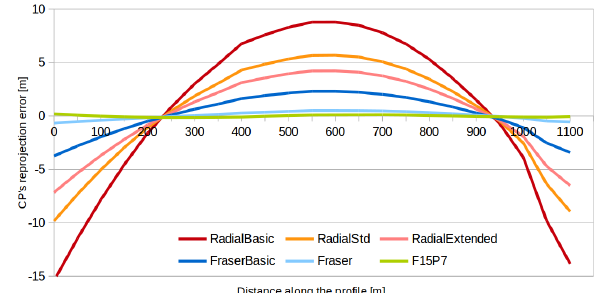
Figure 3: Evolution of the altimetric reprojection error of check points along the profile, for different camera model applied on dataset 2015. The bowl effect is characterized by a parabolic drift of the resulting orientations. Different calibration models implies different drifts, which are minimized for the camera tested by using the most complex characterization of the optical